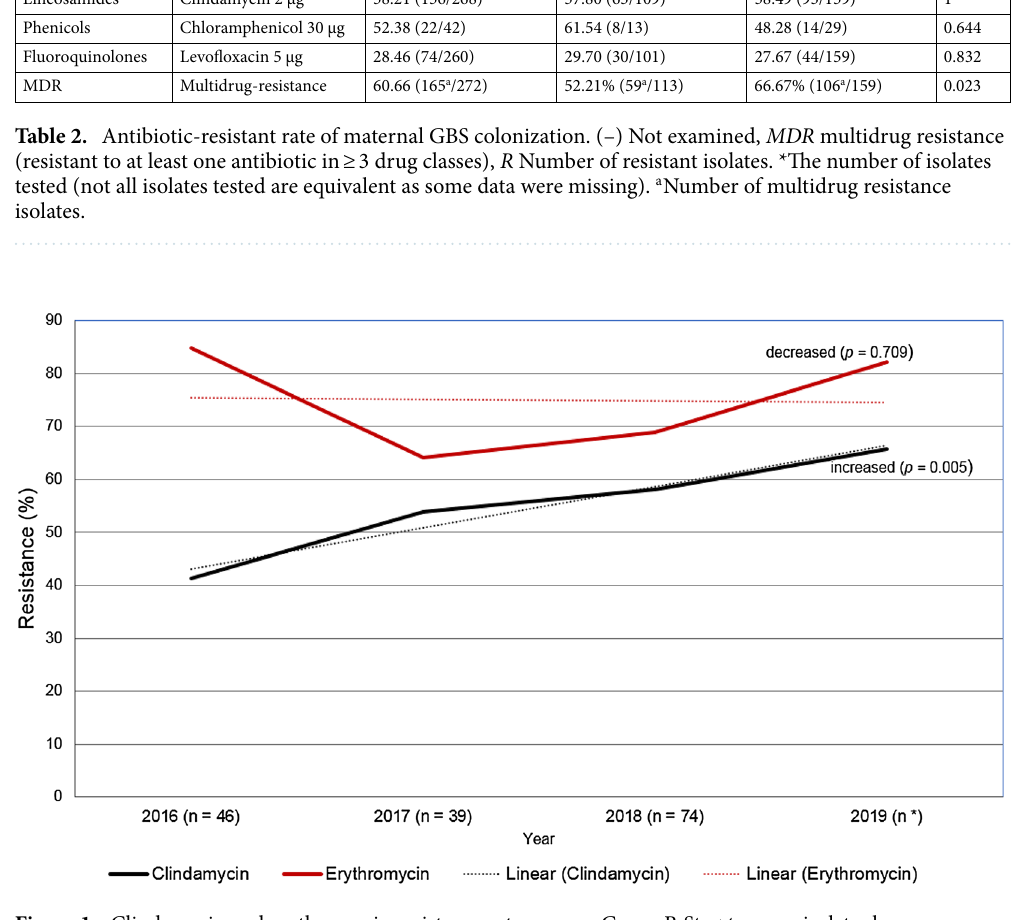
Figure 1. Clindamycin and erythromycin resistance rates among Group B Streptococcus isolates by year. *Clindamycin (n = 102) and erythromycin (n = 101); in 2020, due to the COVID-19 pandemic in Vietnam, only 12 GBS strains (< 30) were collected; thus, the clindamycin and erythromycin resistance rates were not